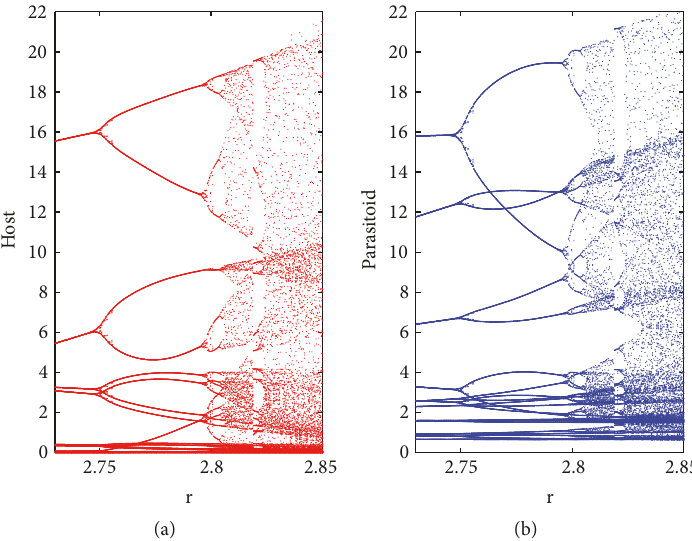
Figure 4: Bifurcation diagram of model (3) with 𝑟 . Parameters are fixed as 𝑎 = 0.45 , 𝜎 = 0.4 , 𝑞 𝑚𝑎𝑥 1 = 0.9 , 𝜃 1 = 0.01 , 𝑞 𝑚𝑎𝑥 2 = 0.1 , 𝜃 2 = 0.5 , 𝜏 = 1.2 , 𝑞 =